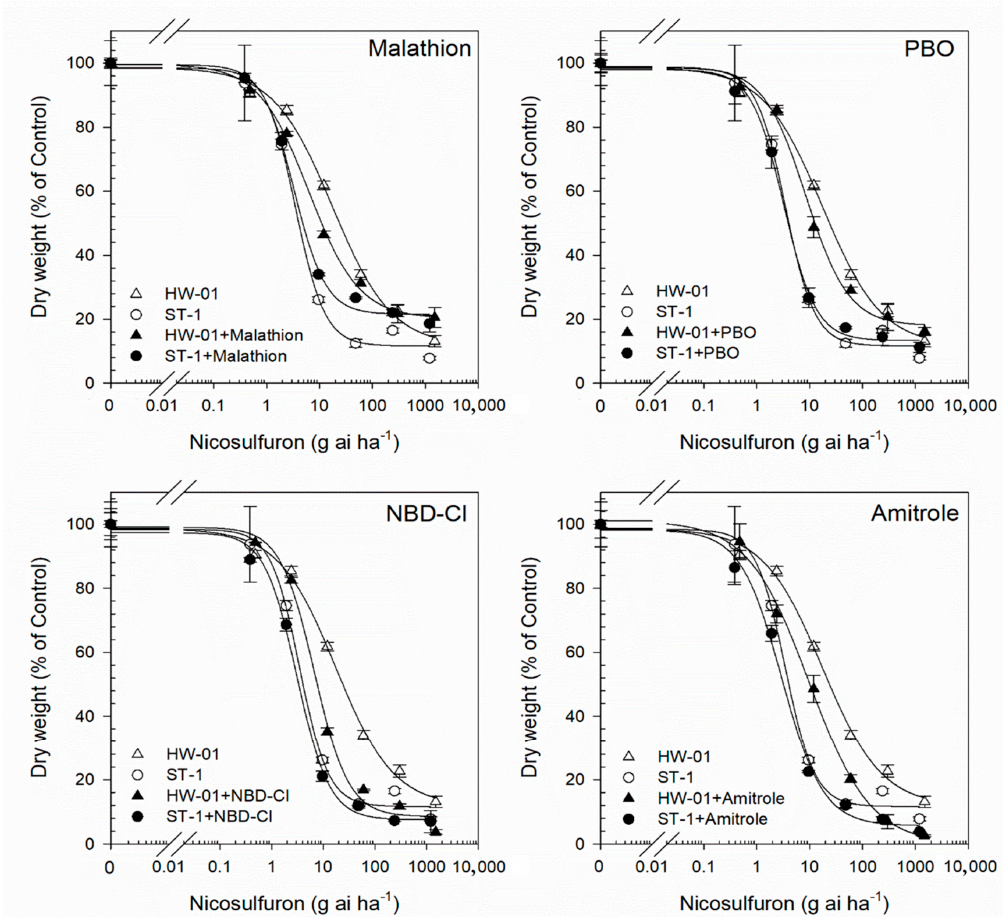
Figure 4. The dose–response curves of the HW-01 population (R) and ST-1 population (S) to nicosulfuron following cytochrome P450 inhibitors (malathion, PBO and amitrole) and GST-inhibitor (NBD-Cl) treatment. Table 4. E ff ect of P450 and GST inhibitors on the resistance of fomesafen and nicosulfuron in A. retro fl exus .